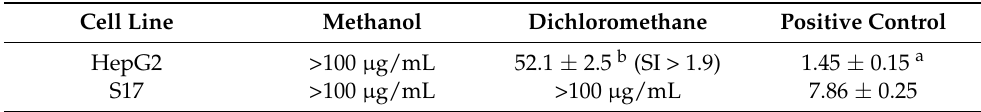
Table 4. Cytotoxic activity of methanol and dichloromethane extracts of the aerial parts of sea heath ( F. laevis ) towards human hepatocarcinoma (HepG2) and mouse bone marrow stromal (S17) cell lines. The results are expressed as half-maximal effective concentration (EC 50 ) values ( µ g/mL). Cell Line Methanol Dichloromethane Positive Control HepG2 Values represent the mean ± standard error of the mean (SEM) of at least three experiments, each performed in triplicate ( n = 9). In the same line, values followed by different letters (a, b) are significantly different at p < 0.05 (Student’s t -test). SI: selectivity index. Positive control: